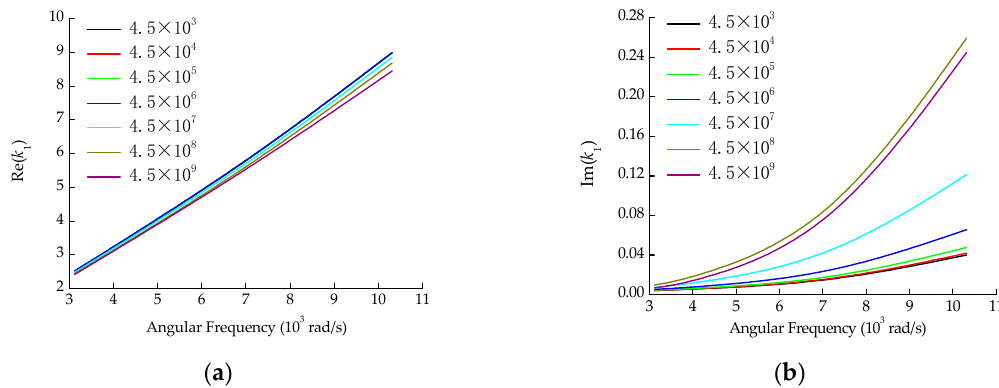
Sensors 2022 , 22 , x FOR PEER REVIEW Figure 2. The influence of soil elastic modulus on wavenumber. ( a ) Real part; ( b ) Imaginary part.